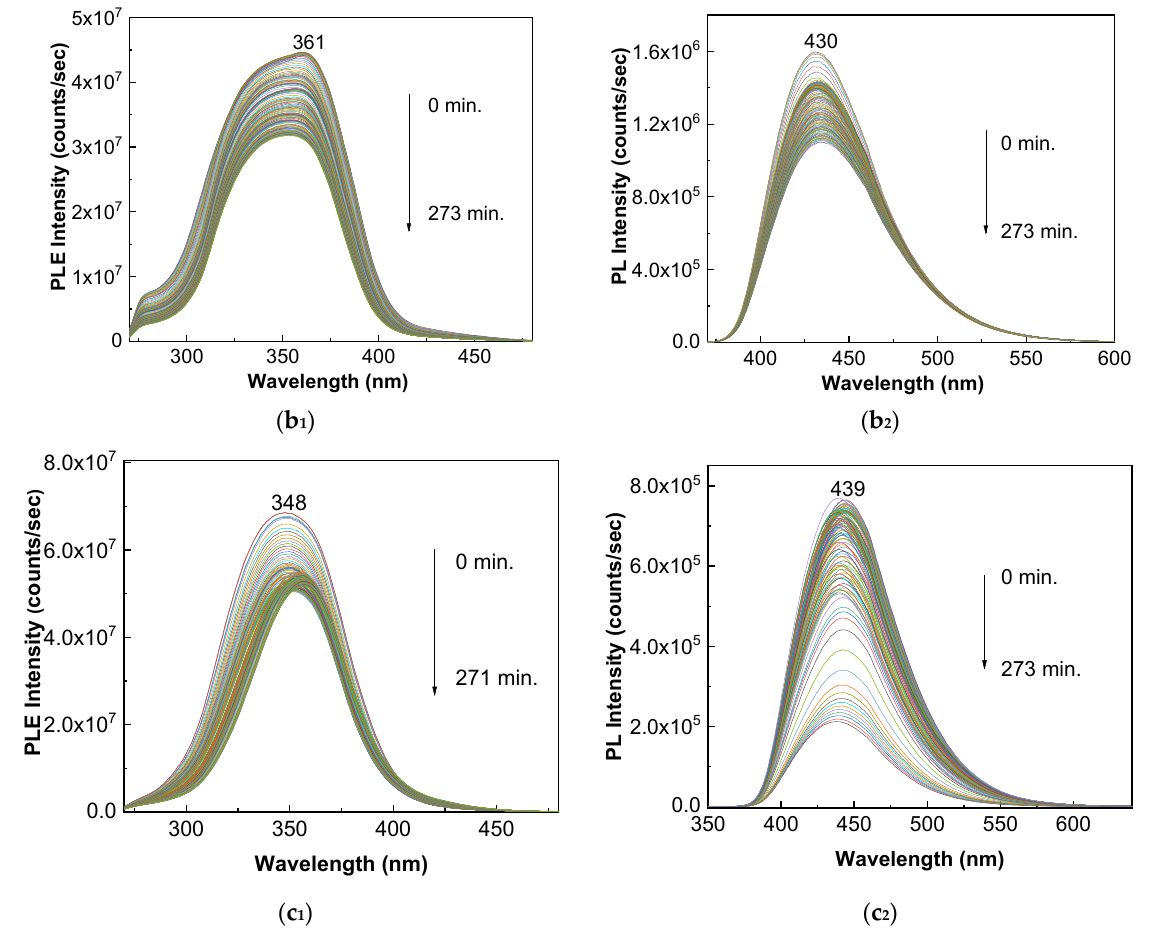
Figure 7. PLE (1) and PL (2) spectra of the AMP drug reacted with NaOH, when the volumetric ratio AMP:NaOH is equal to: 2:1 ( a 1 , a 2 ), 1.5:1.5 ( b 1 , b 2 ) and 1:2 ( c 1 , c 2 ).